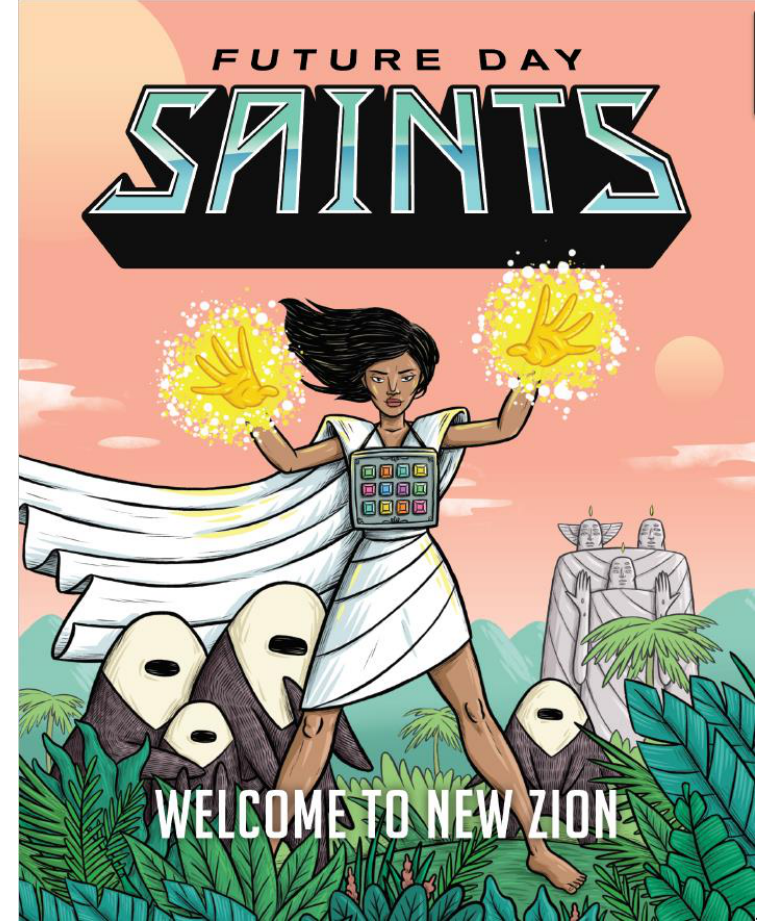
Figure 1. Cover of Future Day Saints. Artist: Matt Page.